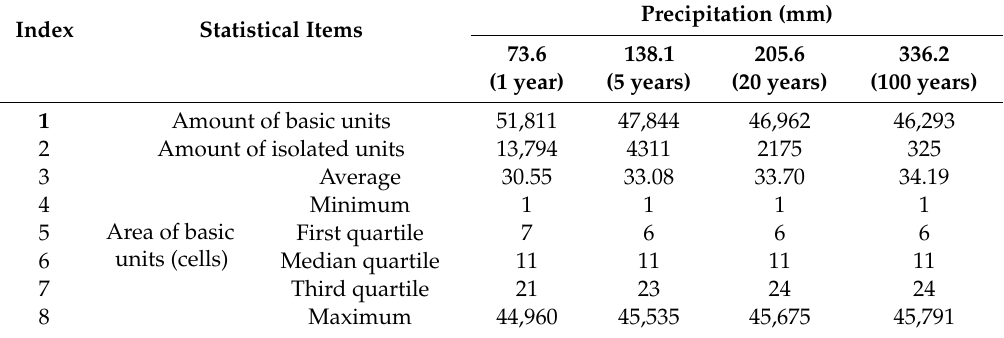
Table 2. The statistical information of basic units in four types of return periods of Wuhan City.